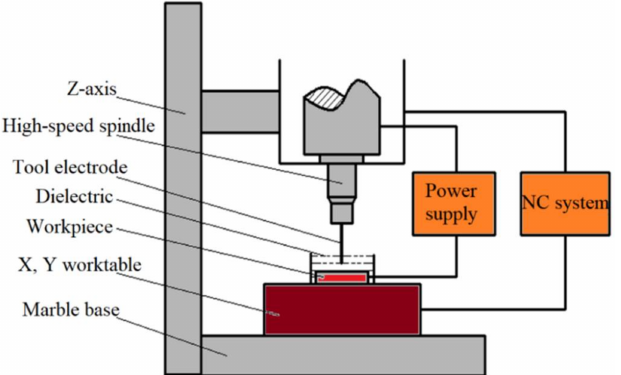
Figure 2. Schematic diagram of microelectrical discharge machining (micro-EDM) platform.